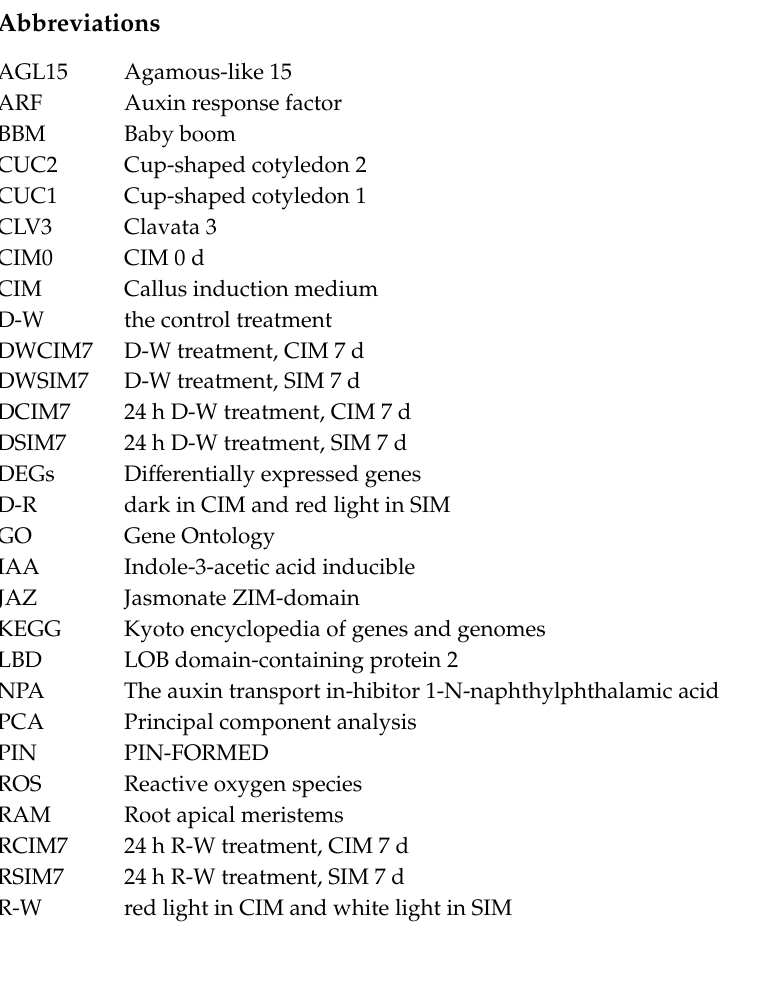
Figure S1: Overall qualitative analysis of the transcriptomics data. Figure S2: Number of DEGs and heat maps of auxin responsive and meristem development genes at comparison of di ff erent processing combinations. Figure S3: Transcriptome analysis of marker genes expression patterns in the CIM and SIM stages. Figure S4: A Western blot shows the kinetic of auxin accumulation in D-3d, R-3d, D-5d and R-5d. Figure S5: Di ff erential genes commonly and KEGG pathway enrichment analysis of DEGs. Figure S6: Gene ontology (GO) annotation and transcription factor prediction in the three stages. Table S1: The meristem development genes were found according to GO analysis. Table S2: The genes of response to red light, far red light and dark were found according to GO analysis. Table S3: The genes of plant hormone response, transport, biosynthesis and oxygen signal were found according to GO analysis. Table S4: Primer sequences of marker genes for callus-induction used in this study. Table S5: Primer sequences of marker genes for shoot-induction used in this study. Table S6: The overall situation of KEGG enrichment pathway genes corrected in the transition stage (DCIM7 vs. DSIM7, RCIM7 vs. RSIM7). Table S7: The overall situation of KEGG enrichment pathway genes corrected in the dedi ff erentiation stage (DWCIM7 vs. DCIM7, DCIM7 vs. RCIM7, DWCIM7 vs. RCIM7). Table S8: The overall situation of KEGG enrichment pathway genes corrected in the primary regeneration shoot stage (DWSIM7 vs. DSIM7, DWSIM7 vs. RSIM7, DSIM7 vs. RSIM7). Table S9: FPKM values of all genes. Table S10: All databases for gene